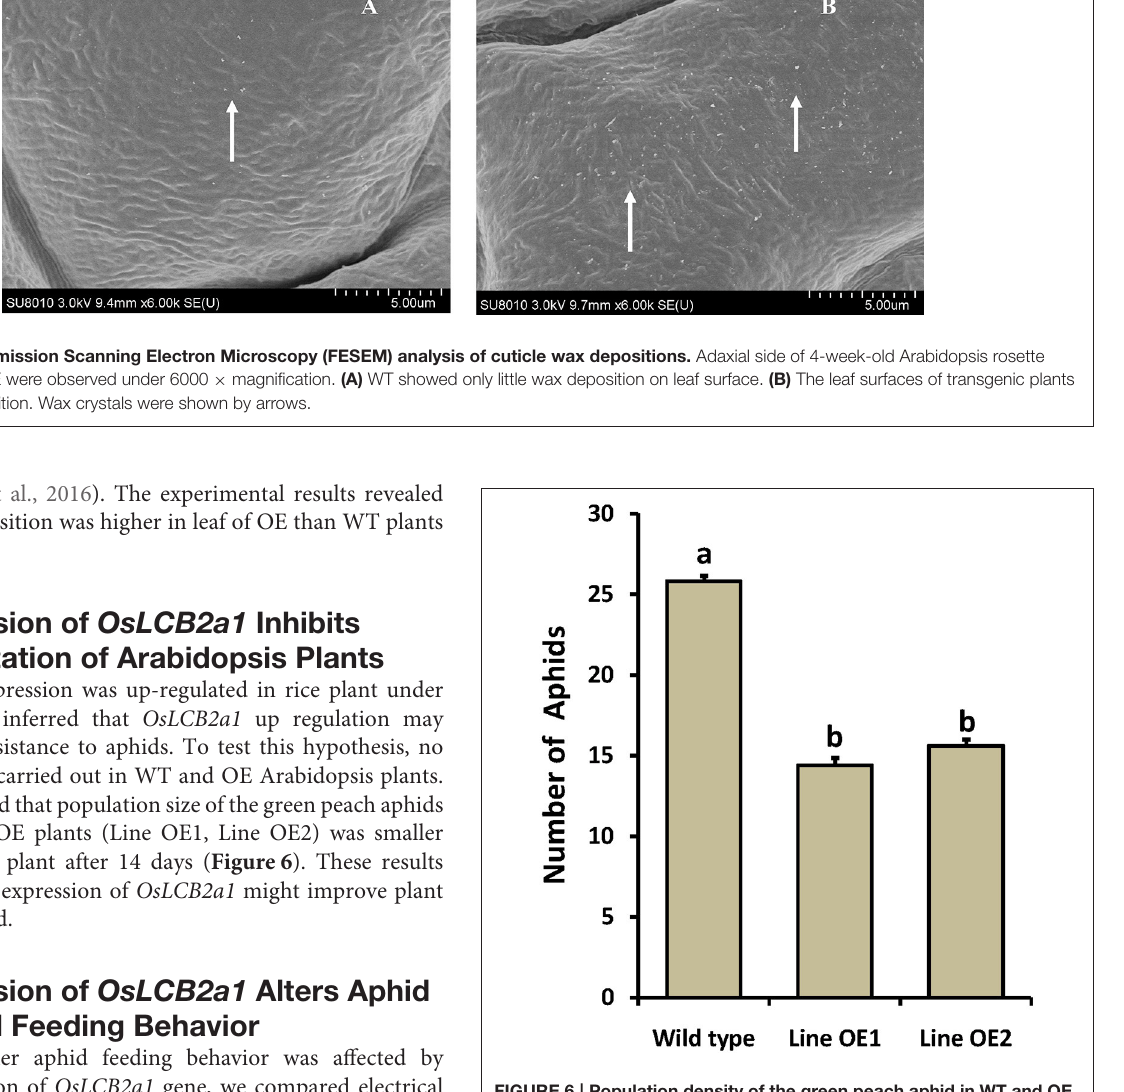
FIGURE 6 | Population density of the green peach aphid in WT and OE Arabidopsis plants. Values represent means ± SE from 15 independent experiments. Different letters indicate significant differences ( P < 0.05) among the